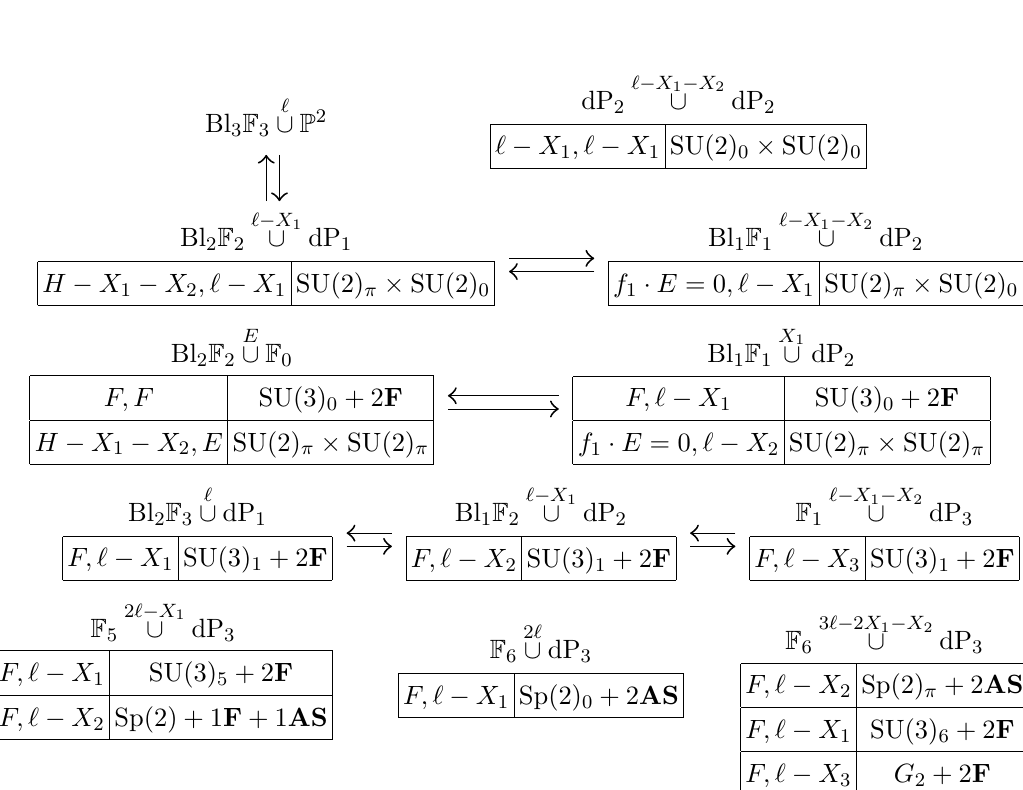
dP 2 at the top, the gluing [